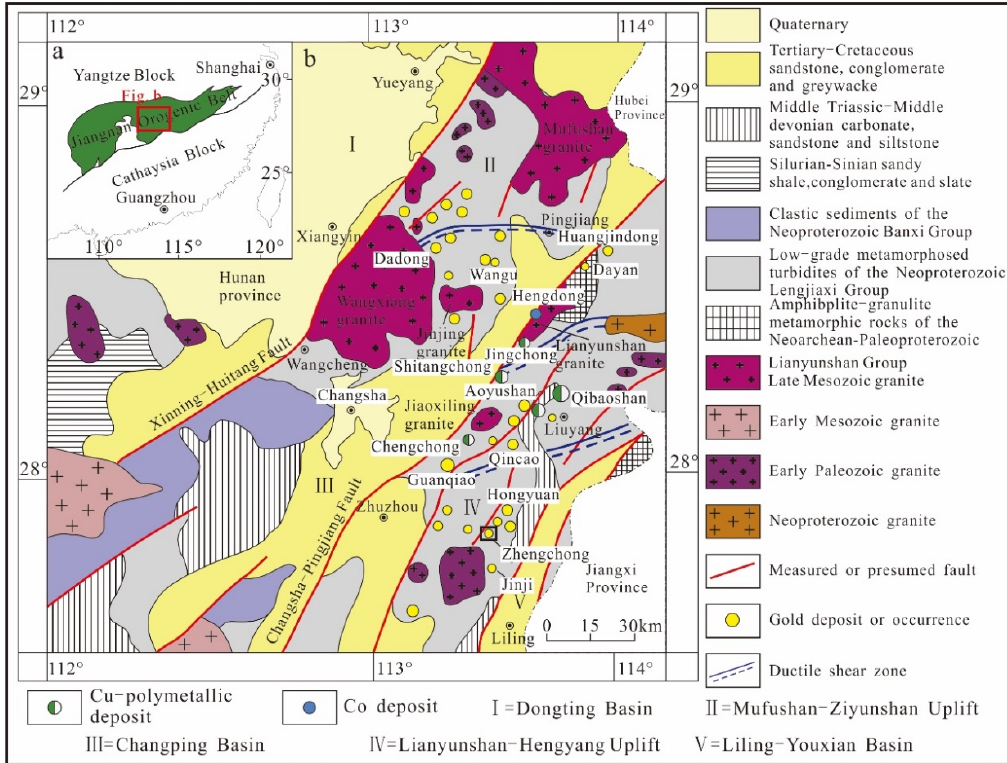
Figure 1. ( a ) Simplified map of South China; ( b ) geological sketch map of northeastern Hunan Province showing the tectonic, magmatic and stratigraphic framework as well as the dominant Au-, Cu- and Co (-polymetallic) ore deposits (modified after [23]).